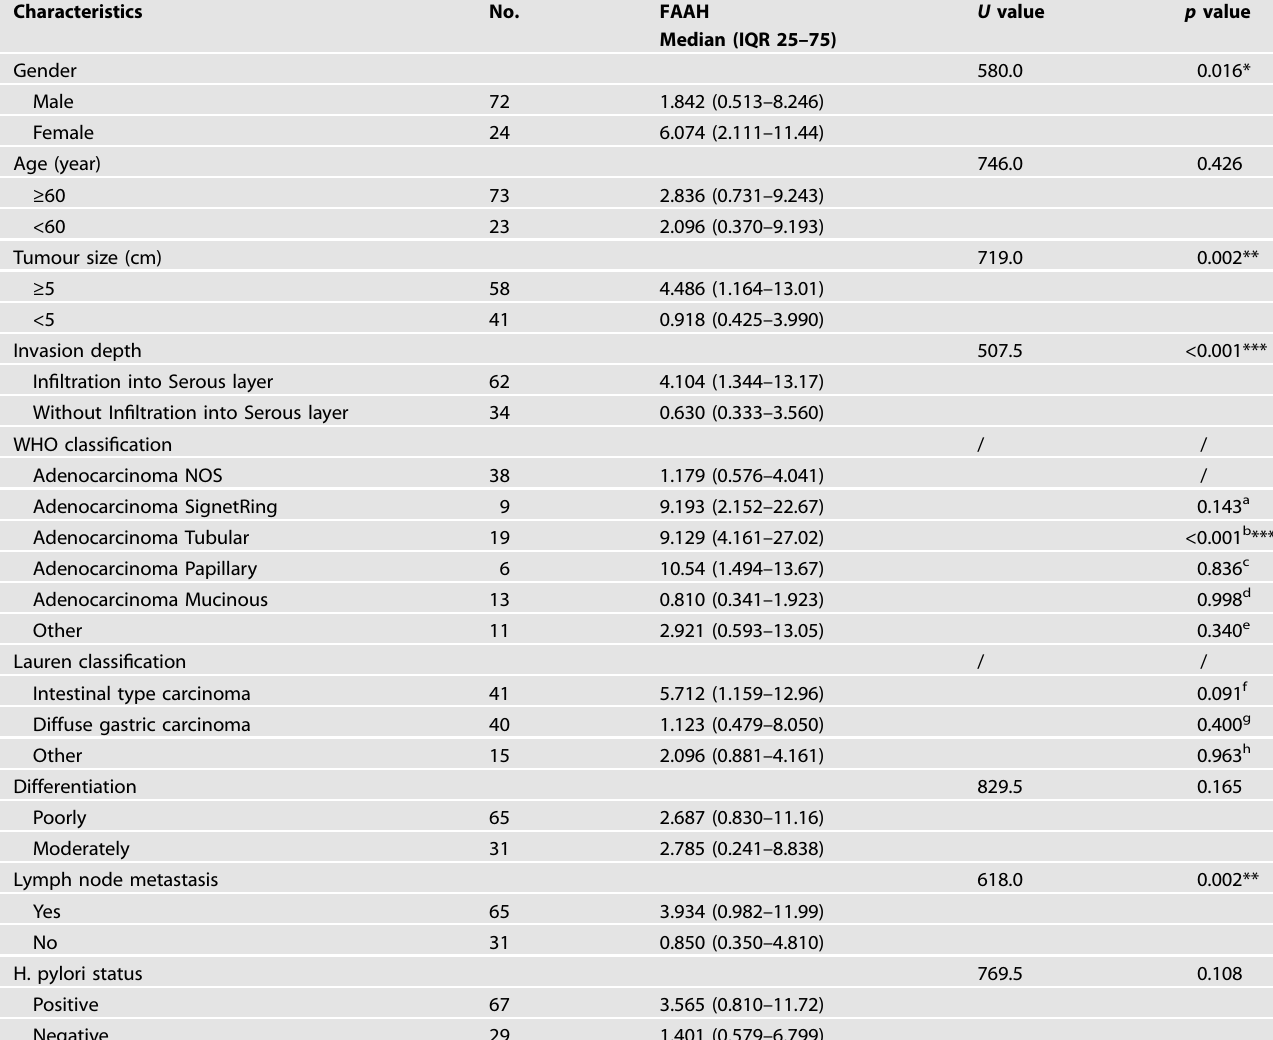
Table 1. The relationship between FAAH expression and clinicopathological characteristics of GC patients.